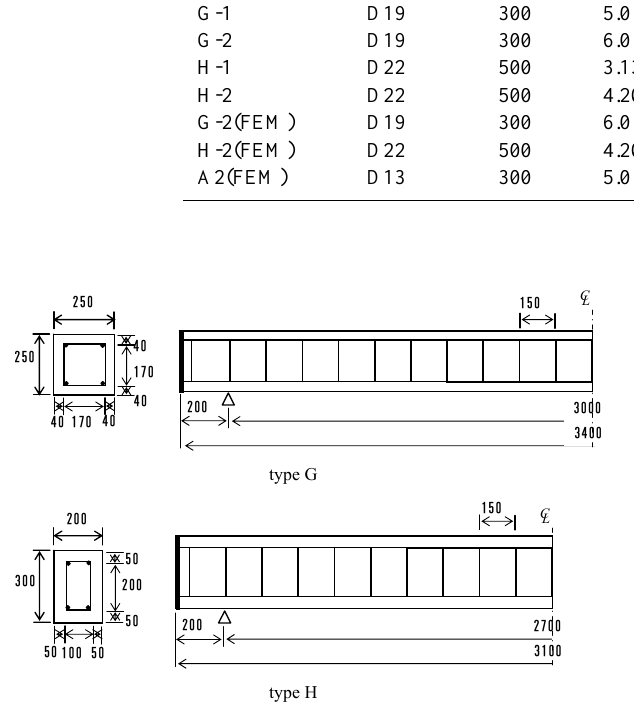
Figure 16. Finite element model of quarter part of the beam and the weight Fig. 16. Finite element model of quarter part of the beam and the